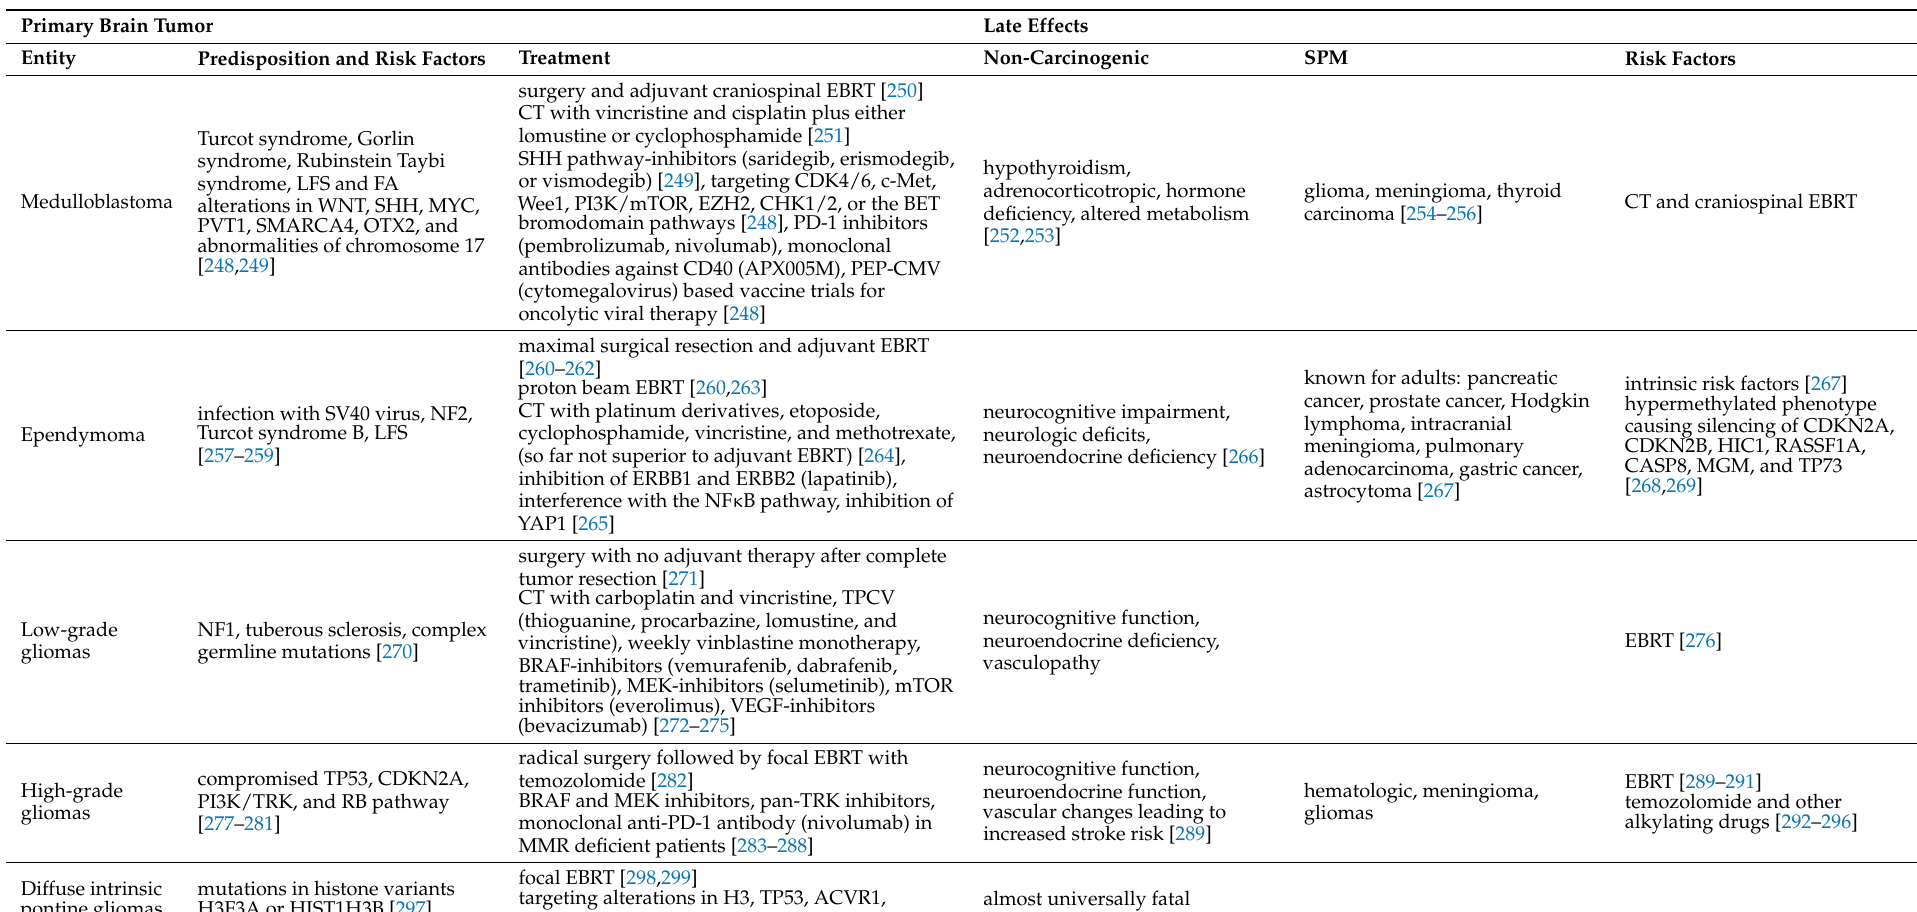
Table 2. Overview of the major primary childhood brain tumors, risk factors for their development, current treatments, non-cancerous late effects, most common second primary malignancies, and risk factors for their